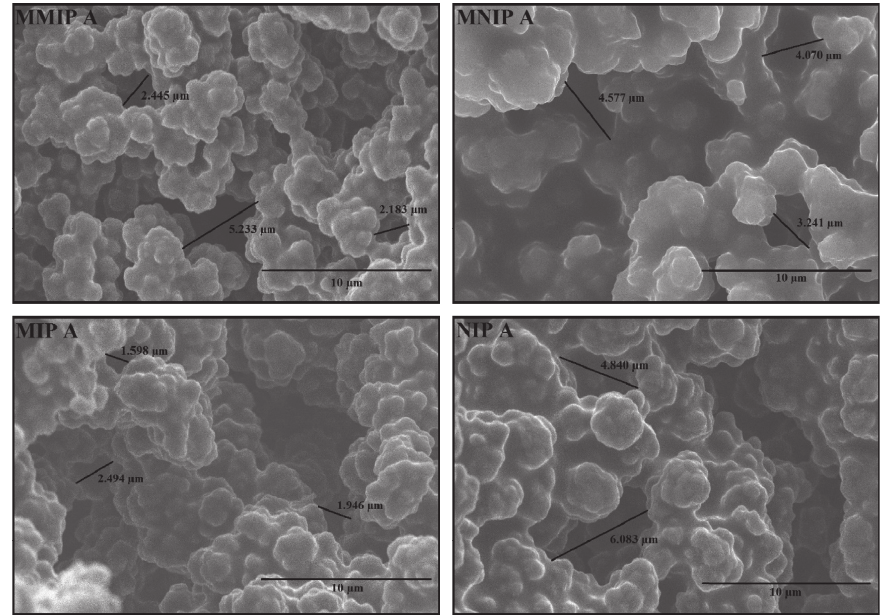
Figure 4: SEM images of monolith prepared with TRIM as the crosslinker at 5000x magnification. The monolith composition can be seen in Table 1.